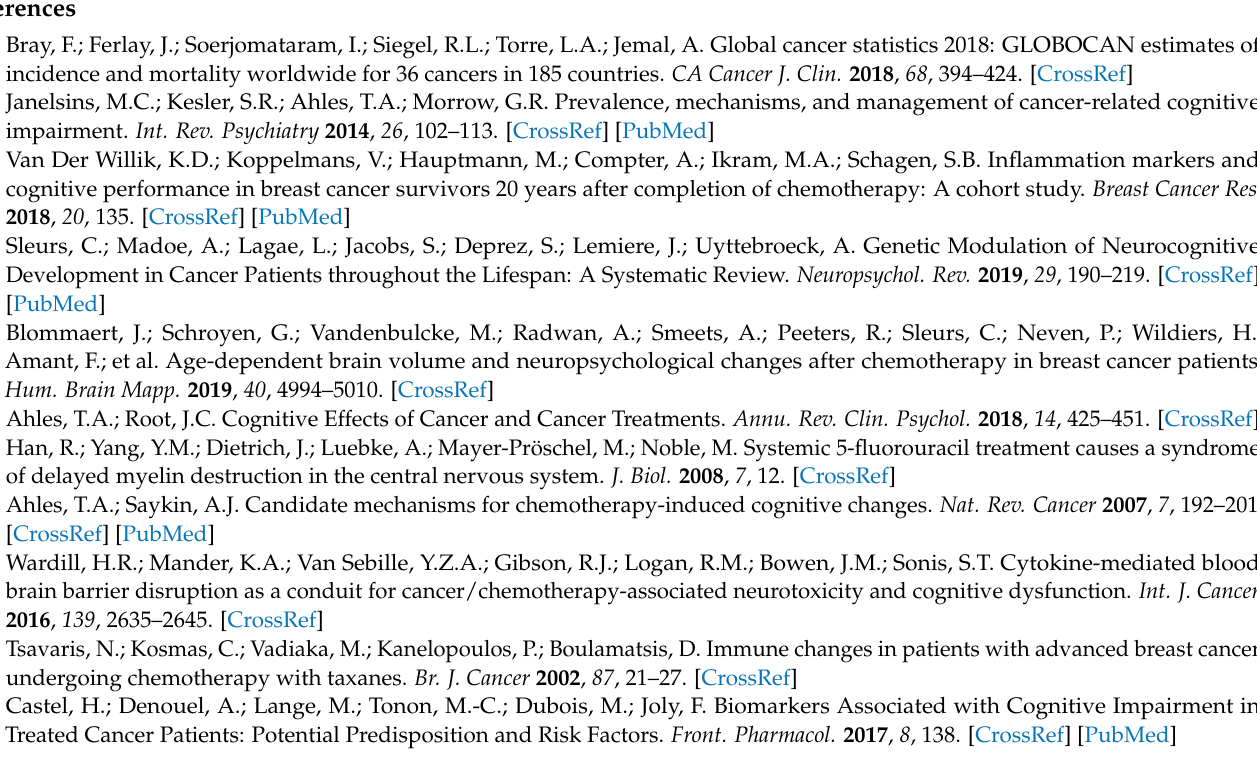
Figure S1: Average parametric LGA V T-ratio images for 15 C+ patients, 15 C − patients and 15 HC, Figure S2: Regions showing [ 18 F]DPA714 V T-ratio differences with 2TCM + vascular trapping, Supple- mentary materials and methods, Supplementary